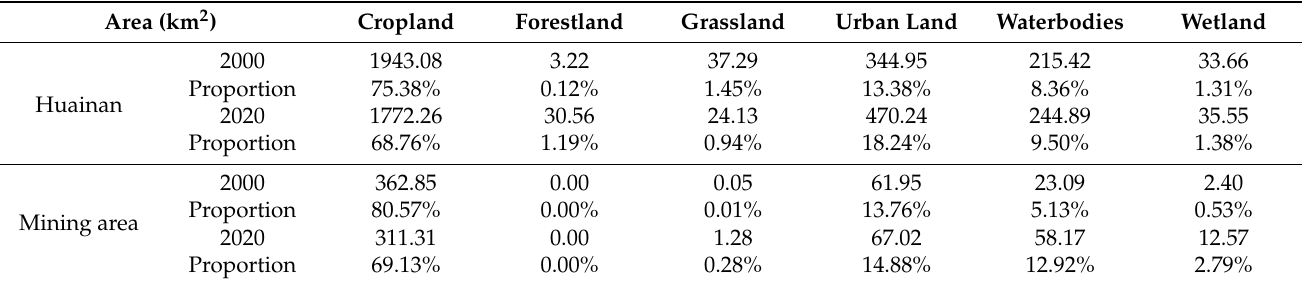
Table 5. Land-use structures in Huainan and mining areas from 2000 to